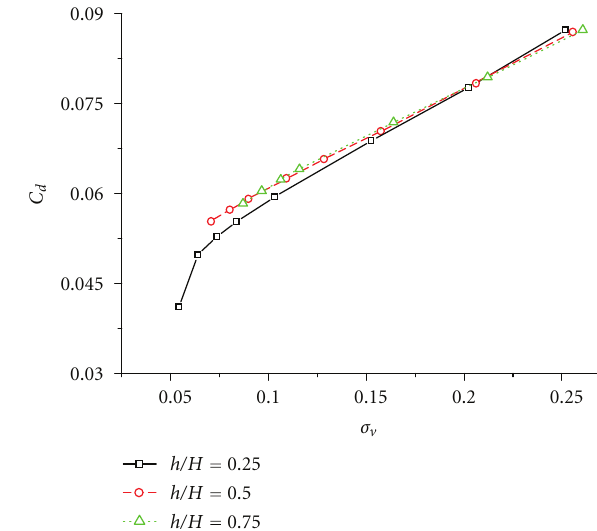
Figure 18: Relations between C d and σ v .